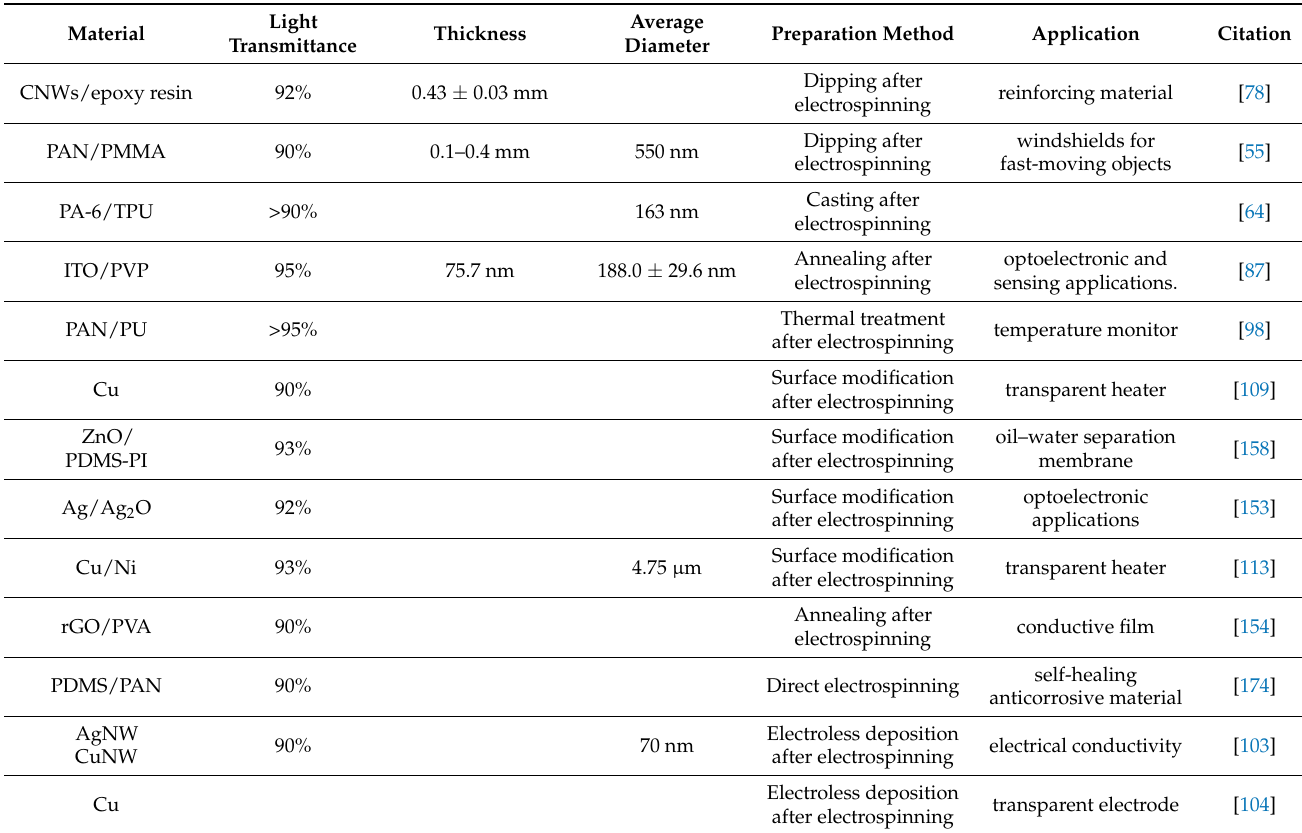
Table 1. Materials, preparation methods, film thickness, average diameter, and application fields of nanofibrous films with light transmittance above